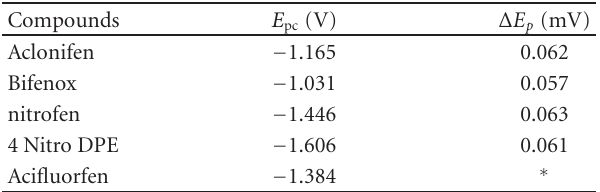
Table 1: Reduction of nitro diphenyl ether derivatives. Acetonitrile,